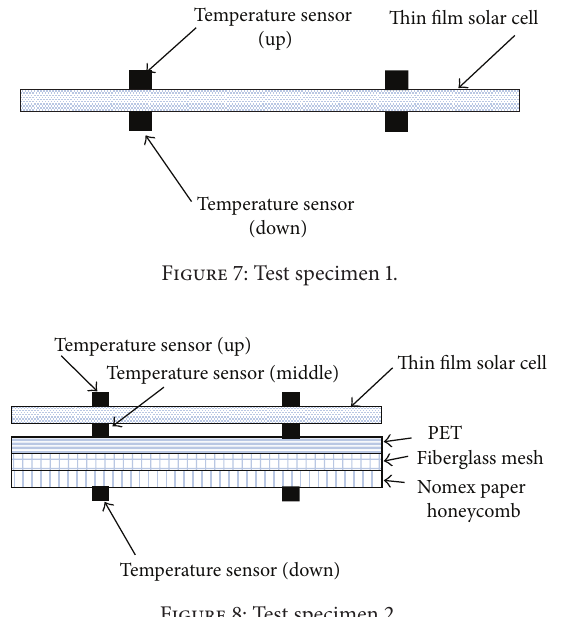
Figure 8: Test specimen